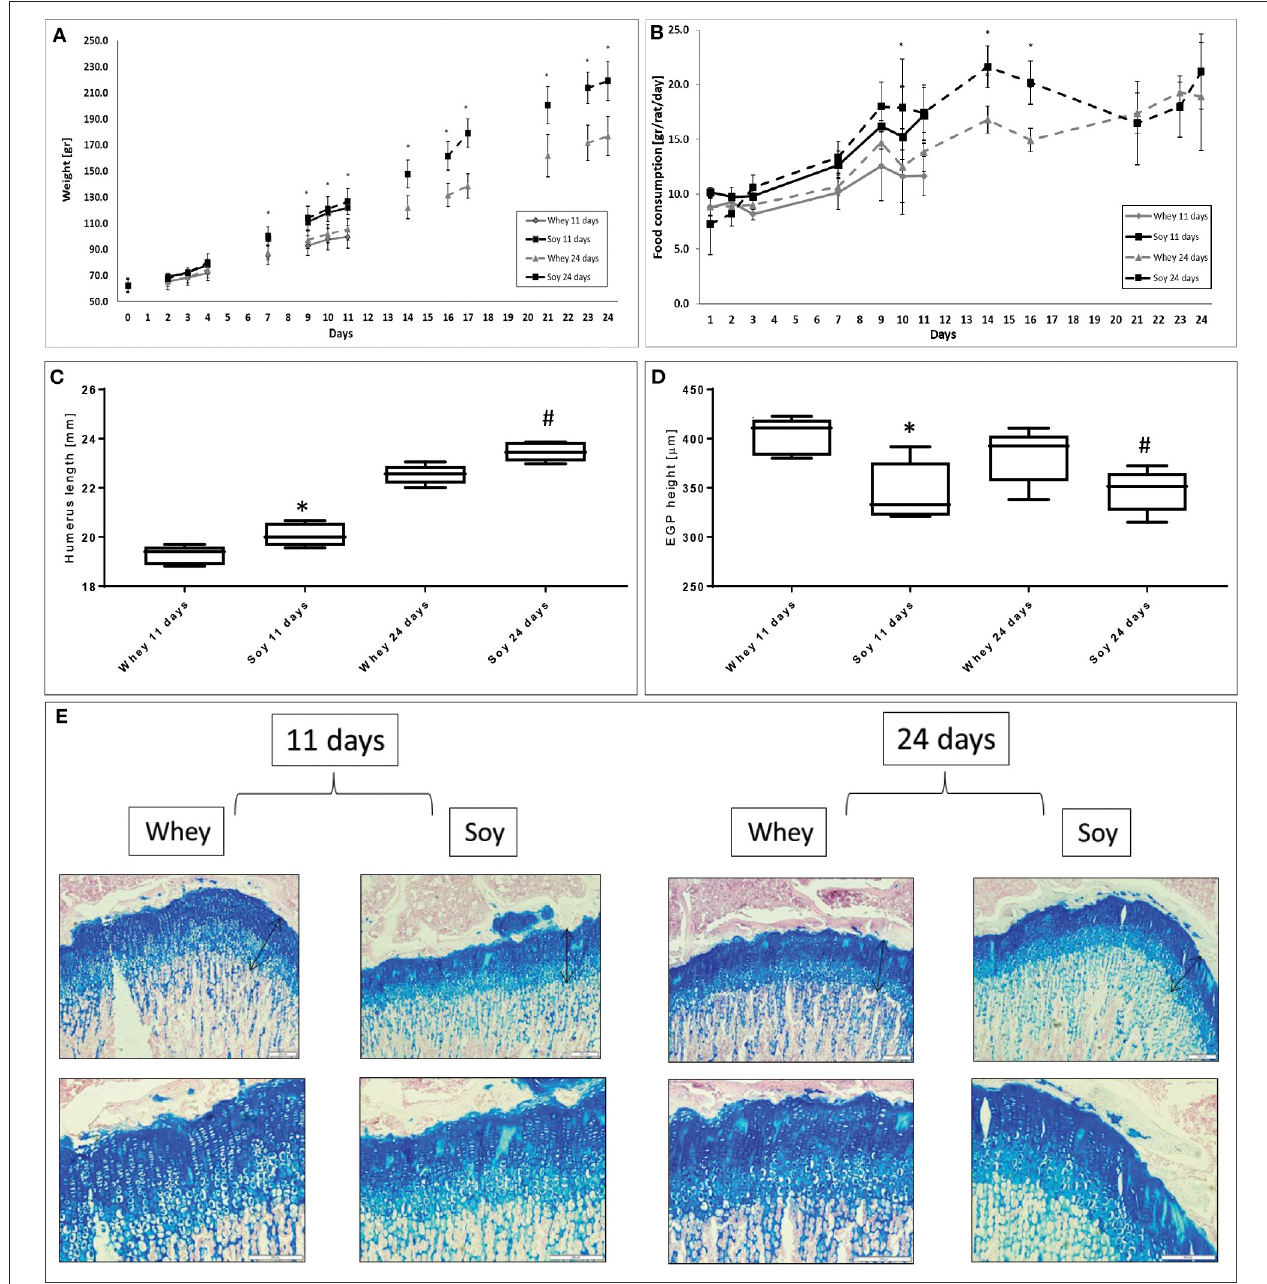
FIGURE 1 | Differential effect of soy and whey diets on growth during 11 or 24 days of ad libitum feeding. (A) Body weight, (B) food consumption, (C) humerus length, (D) EGP height, and (E) representative stained sections of the EGP (upper panel-magnification × 10; lower panel -magnification X 20). Statistical analysis was done by Student’s T -test. The asterisk (*) within the graphs designates significant differences at p < 0.05 for whey vs. soy at 11 days; The pound sign (#) within the graphs designates significant differences at p < 0.05 for whey vs. soy at 24 days. The black arrows indicate the height of the growth plates. (C,D) The box plot shows the minimum, first quartile, median, third quartile, and maximum in humerus length (C) and EGP height (D) after 11 and 24 days of free feeding. EGP, epiphyseal growth